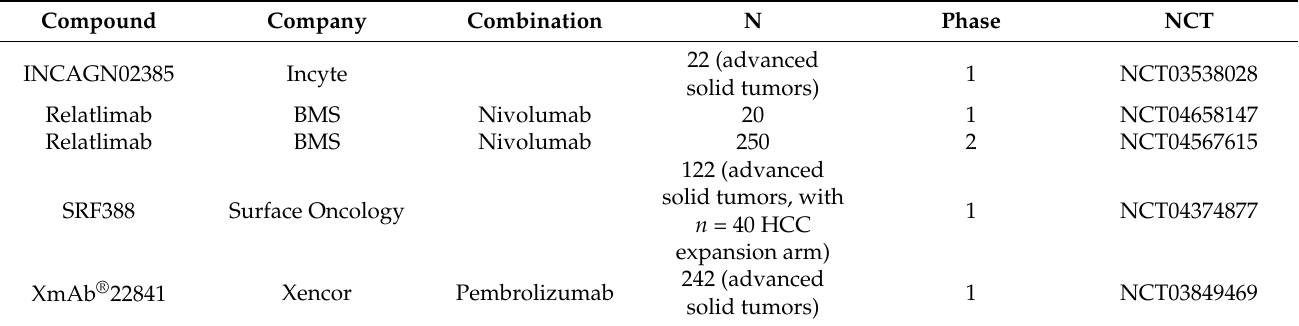
Table 4. LAG-3 inhibitors investigated in